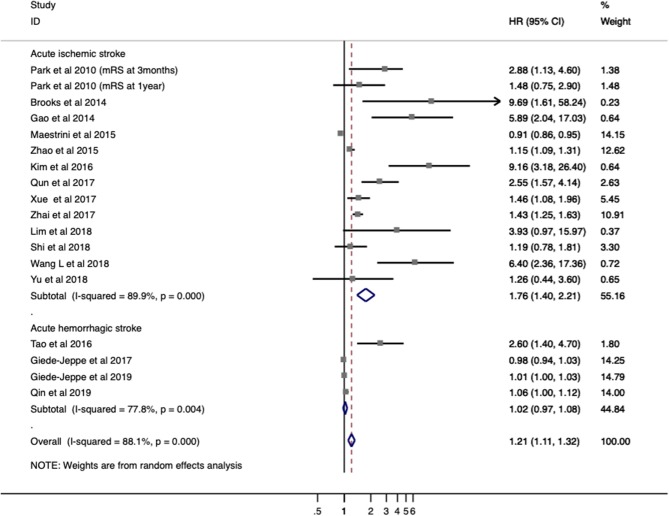
Meta-analysis of the association between NLR and modified Rankin Scale (mRS) functional outcome in patients. Results are presented as individual and pooled risk ratios (RRs) with 95% confidence intervals (CIs).